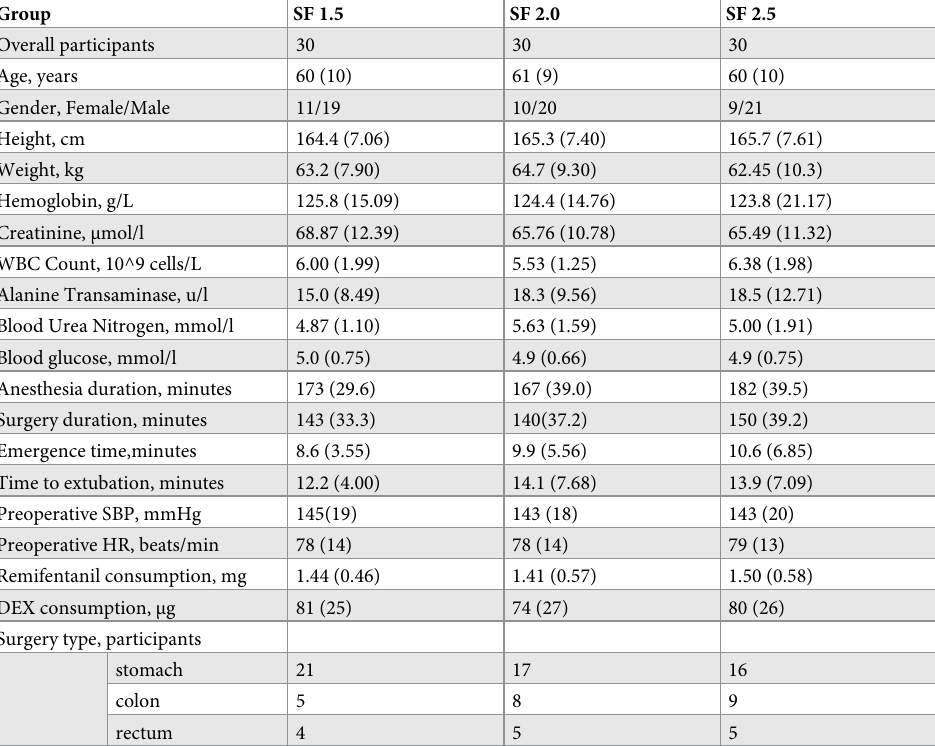
Table 2. Patients’ baseline characteristics and operational data.